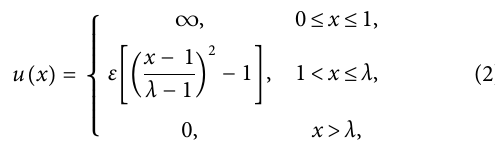
Frontiers in Physics |